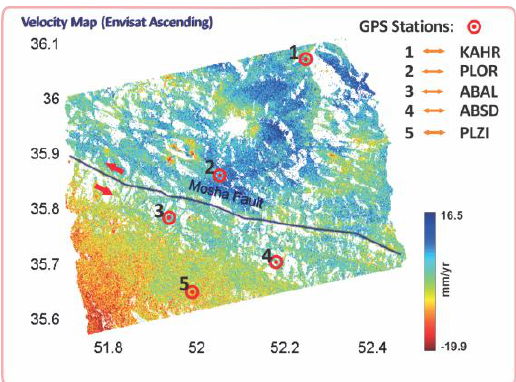
Figure 4: Final velocity map for our study area. The horizontal component of movement Mosha fault (Left lateral) is detected correctly through processing. All the red circles indicate GPS stations around Damavand volcano and Mosha